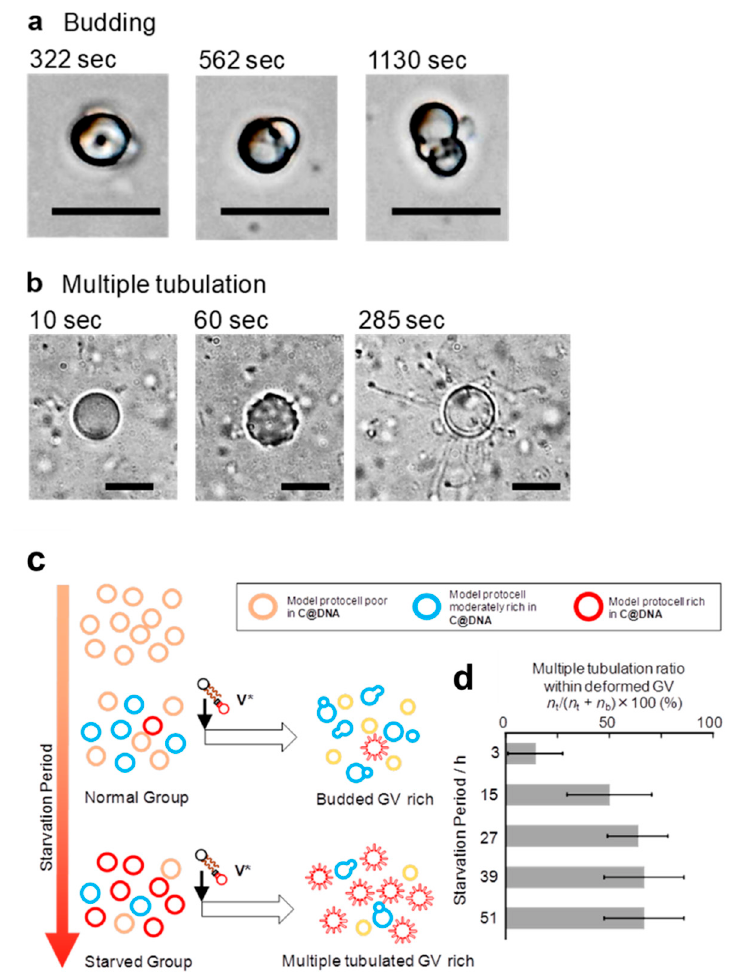
Figure 2. Two patterns of morphological changes observed by the addition of V* after starvation periods: DIC microscopy images of the budding ( a ), the time-lapse morphological changes to the multiple tubulation ( b ), followed by addition of membrane precursor V* . Scale bars represent 10 μ m. Schematic illustration of the starvation period-dependent crossover from a normal group to a starved group ( c ), dependence of ratios of multiple tubulation to the whole morphologically changed GVs on the starvation periods. The ratio of multiple tubulation to total changes (multiple tubulation + budding) increased from 14% (2/14 protocells) after 3 h to 50% (3/6) after 15 h, and eventually saturated at ca. 65% (7/11), (4/6), (4/6) after 27, 39, and 51 h, respectively. The total number of GVs was obtained through 10 experiments. Error bars represent the confidence interval of 95% on the basis of the two-term distribution ( d ).